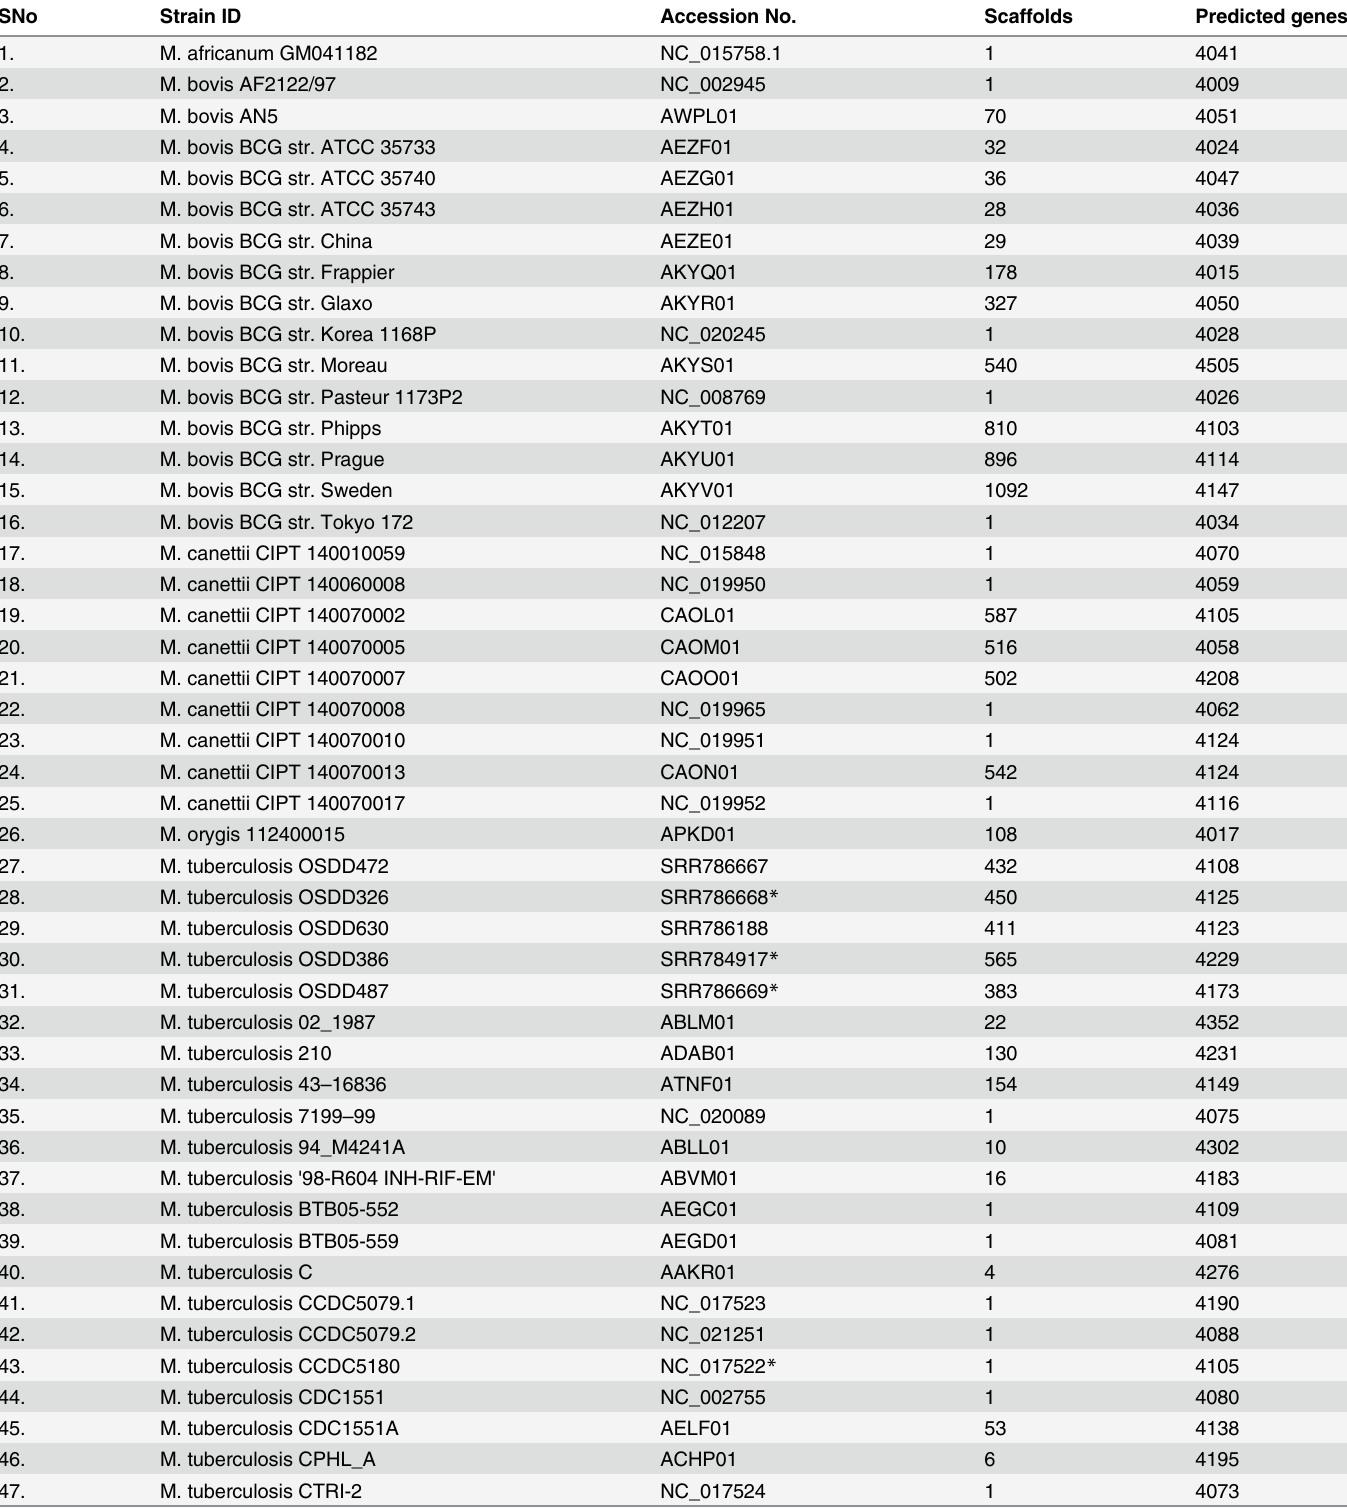
Table 1. Salient features of the 96 M . tuberculosis complex genomes used in the present